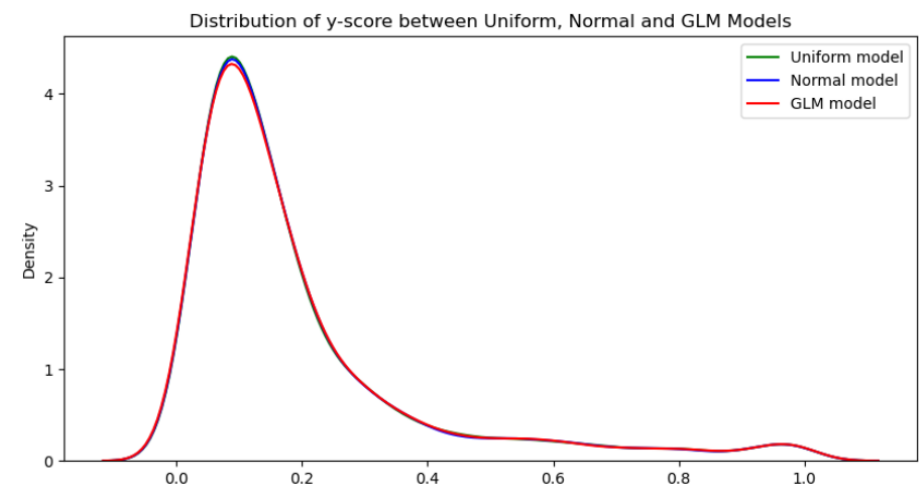
Figure 14. Distribution of the y-score for Bayesian using uniform, normal, and built-in GLM priors. for the Bayesian models (uniform, normal, and GLM) were similar amongst the three.